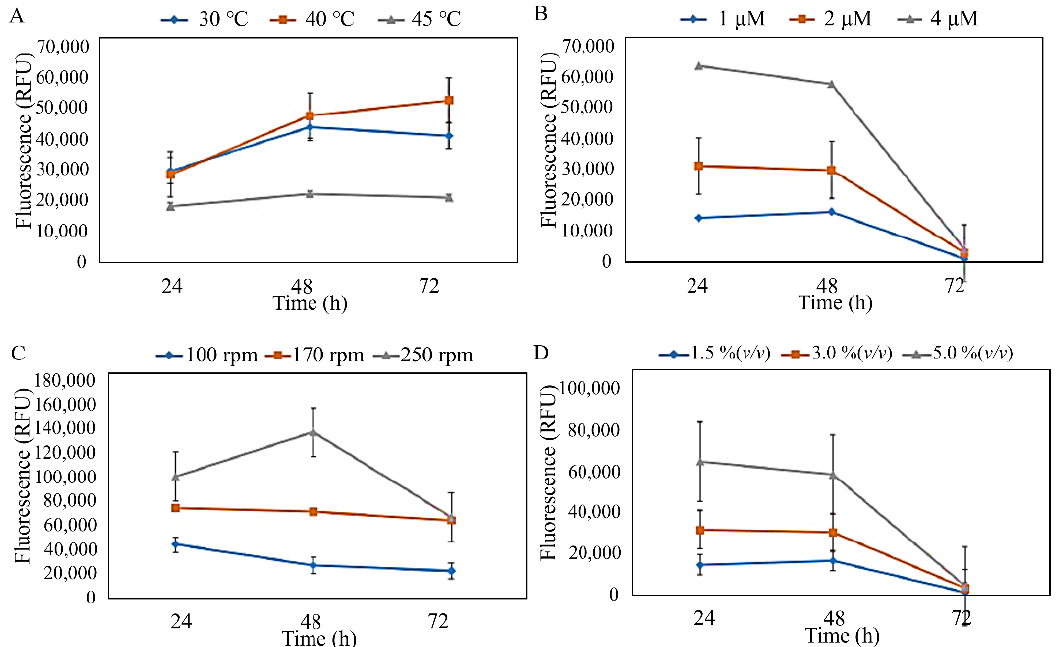
Figure 3. Identification of suitable culture parameters for PHA biosynthesis by S. mizutaii UMTKB-6 cultured in sucrose. ( A ). Effect of temperature on PHA production, ( B ). effect of MgSO 4 ·7H 2 O concentration on PHA production, ( C ). effect of agitation on PHA production, ( D ). effect of inoculum concentration on PHA.